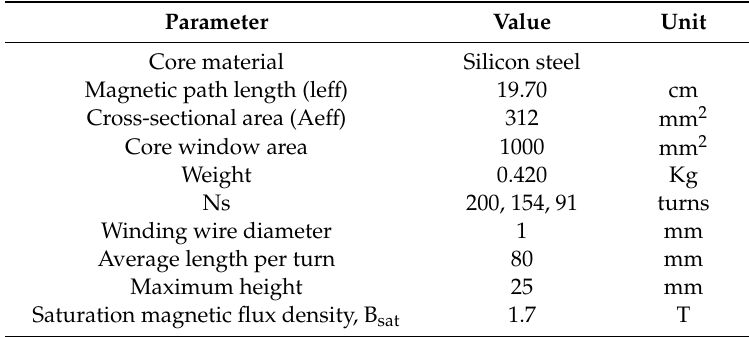
Table 3. Harvester